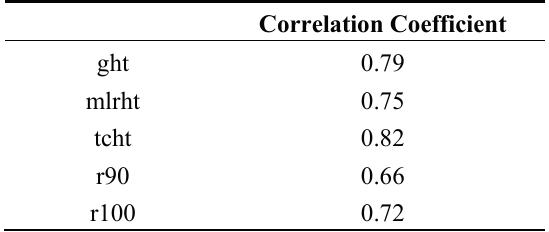
Table 4. Correlation coefficients for the RT models for the five GLAS-derived canopy height versions.